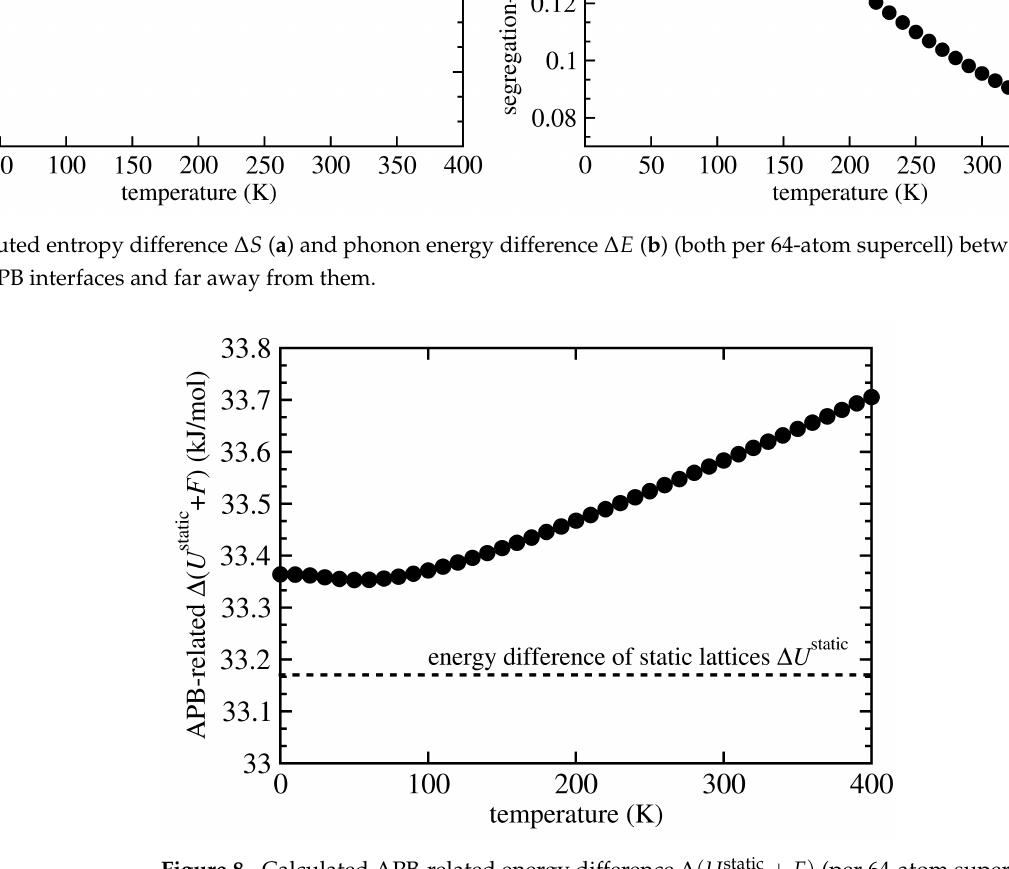
Figure 8. Calculated APB-related energy difference ∆ ( U static + F ) (per 64-atom supercell) between (i) the state with two Cu atoms at the APB interfaces and (ii) the state without APBs as a function of temperature in comparison with the static lattice difference (see horizontal dashed line). The elementary entity for defining one mole is the 64-atom